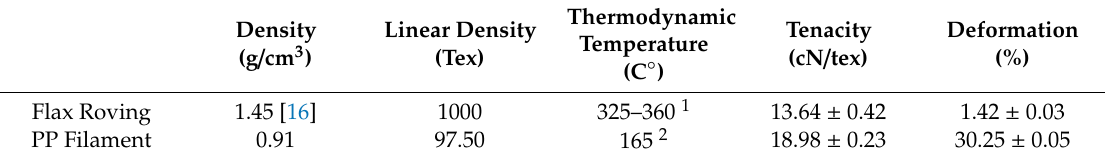
Table 1. The main properties of raw